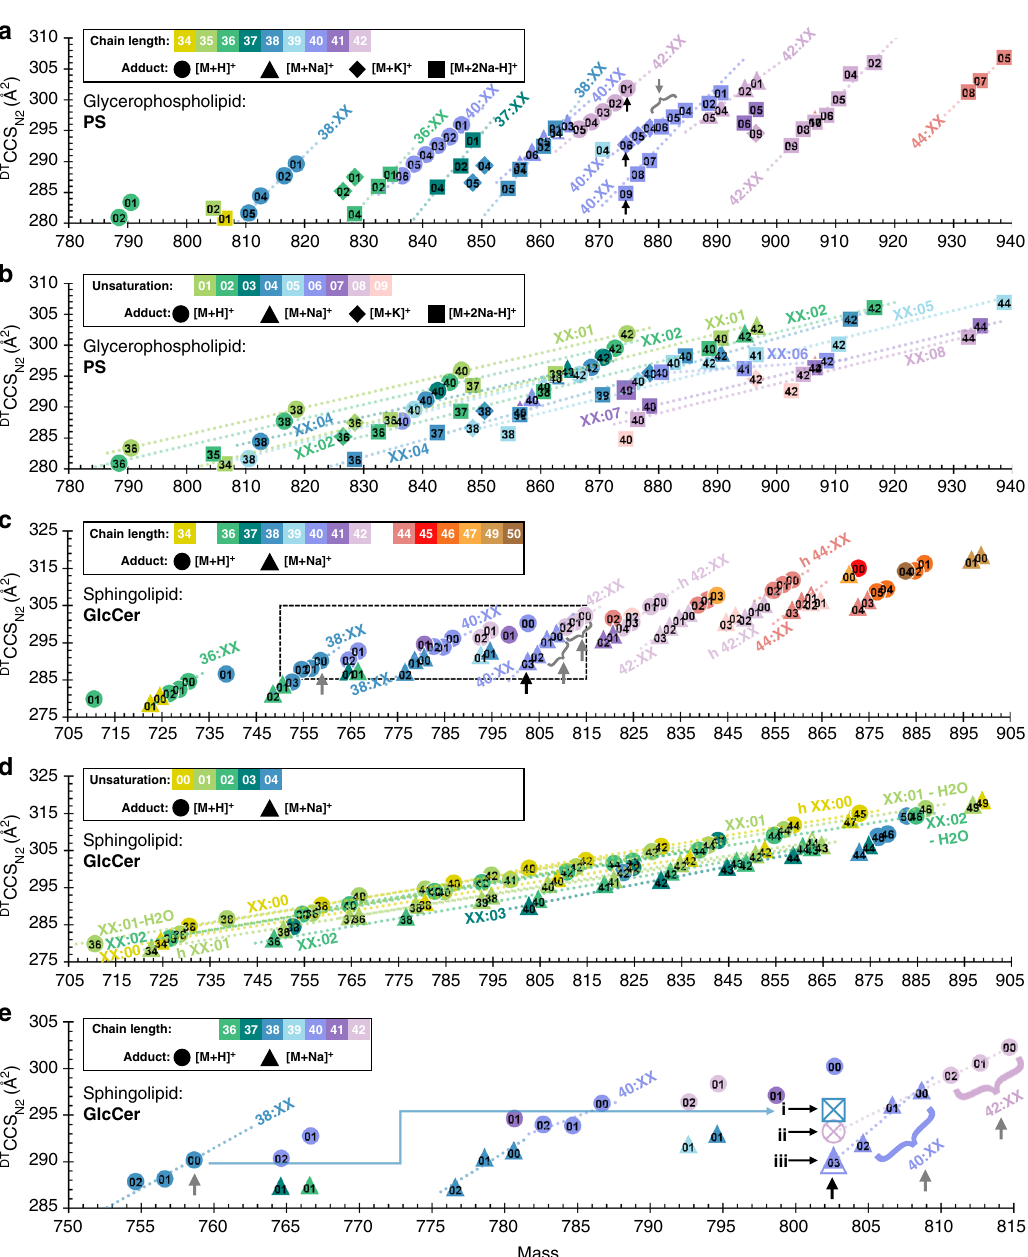
Fig. 4 Quantitative correlations within the cation data for PS and GlcCer lipid classes. a , b DT CCS N2 of PS lipids. For the same carbon chain length, PS lipids increase linearly in DT CCS N2 with each loss of unsaturation ( a ). For the same degree of unsaturation, DT CCS N2 values increase linearly with PS acyl chain length ( b ). c , d DT CCS N2 of GlcCer lipids. GlcCer species exhibit longer chain lengths than PS, however, the same linear trends are observed for both number of double bonds ( c ) and for carbon chain length within the same double bond category ( d ). e A closer inspection of the boxed region highlighted in c demonstrates identi fi cation of the initially unknown lipid feature at 802.616 Da, 290.3 Å 2 (denoted by a black arrow). Based on the quantitative DT CCS N2 trends, the lipid feature is lower in DT CCS N2 than the predictions for both GlcCer 38:00 + 2Na – H (295.8 Å 2 , indicated as (i)) and GlcCer 42:06 + H (293.1 Å 2 , indicated as (ii)). However, the unknown feature aligns well with the DT CCS N2 predicted for GlcCer 40:03 + Na (290.1 Å 2 , indicated as (iii)), enabling high con fi dence identi fi cation of this lipid. Colors correspond to either summed chain length or degree of unsaturation, whereas shapes correspond to cation type, as speci fi ed in the corresponding panel legends. Numerical annotations within symbols correspond either to degree of unsaturation or carbon length, depending on the panel. Error bars represent standard errors for the DT CCS N2 measurements and are all within the size of the markers. Speci fi c lipid identi fi cations, numerical measurement data, and number of measurements per data point ( n = 8 or 16 repeat measurements for positive ionization mode data, n = 20, 21, or 28 repeat measurements for negative ionization mode data) are provided in Supplementary Data 1. Information for linear fi ts including slopes, R-squared values, and number of points per trend line are provided